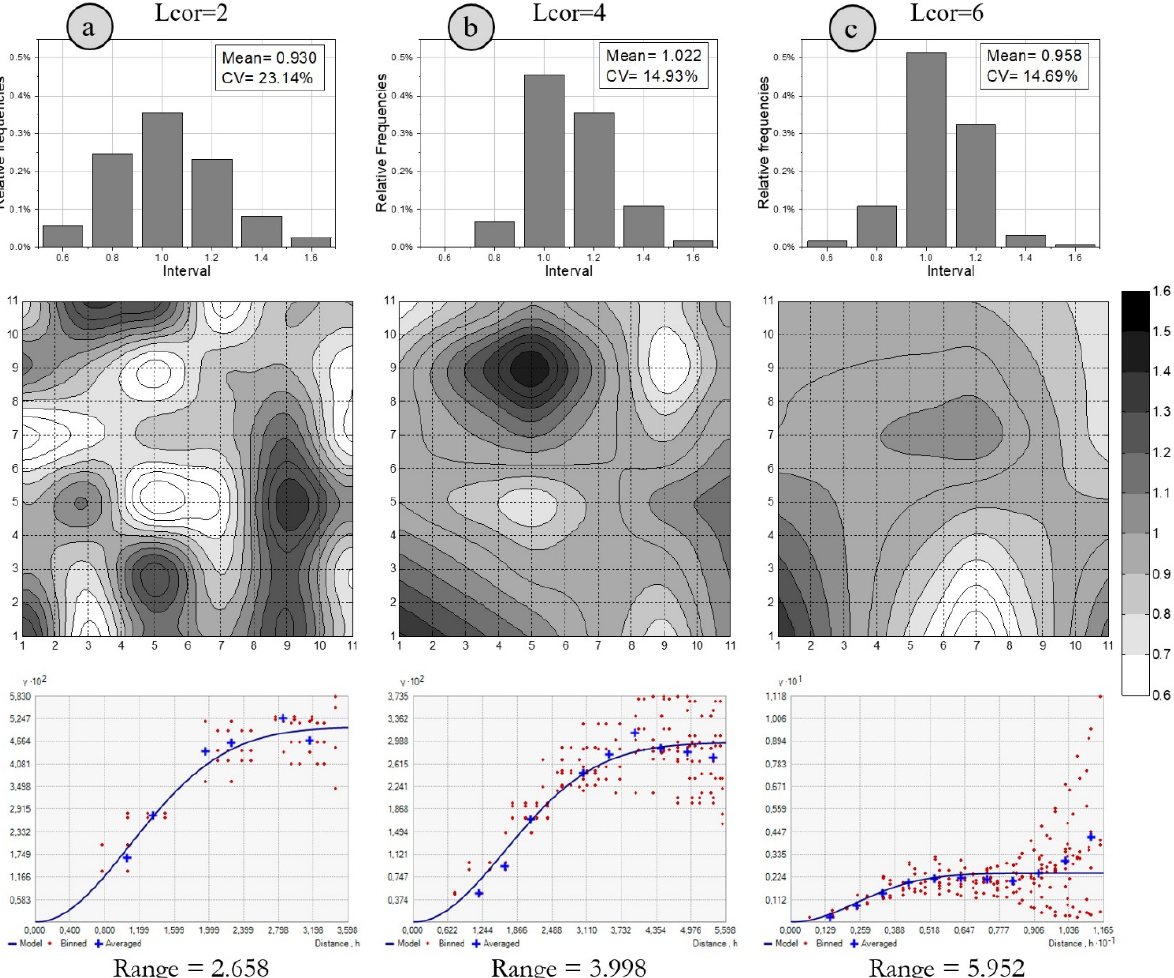
Figure 6. Histogram after the interpolation of the poles, Spatial Distribution and Semivariogram of the numerical simulation with a) Lcor = 2, b) Lcor = 4 and c) Lcor =